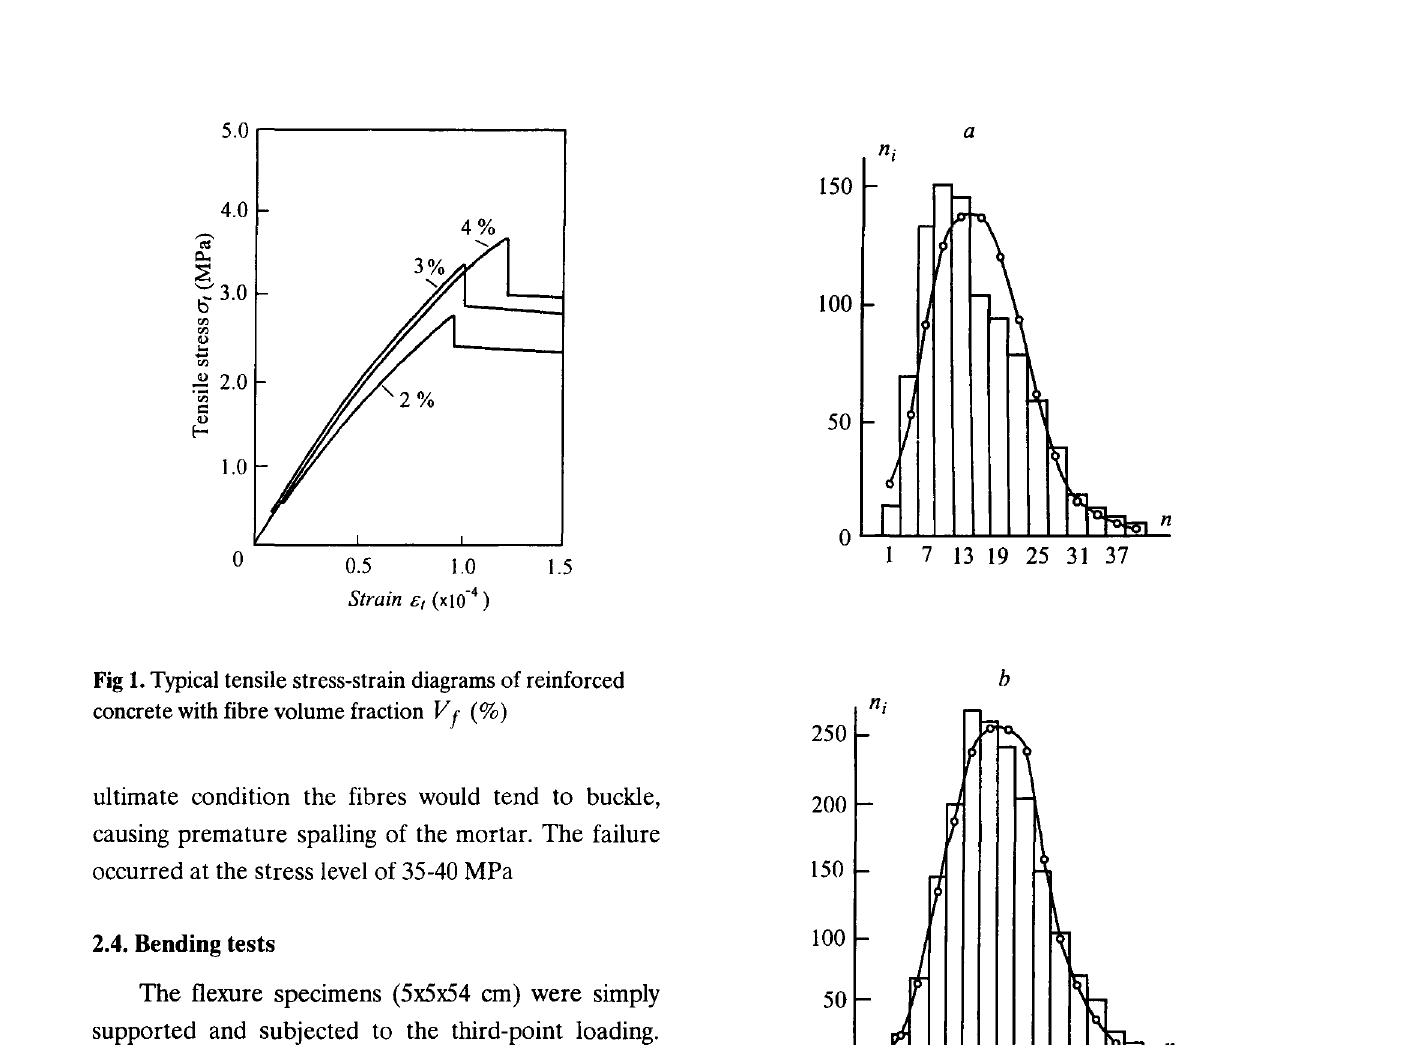
Fig 1. Typical tensile stress-strain diagrams of reinforced